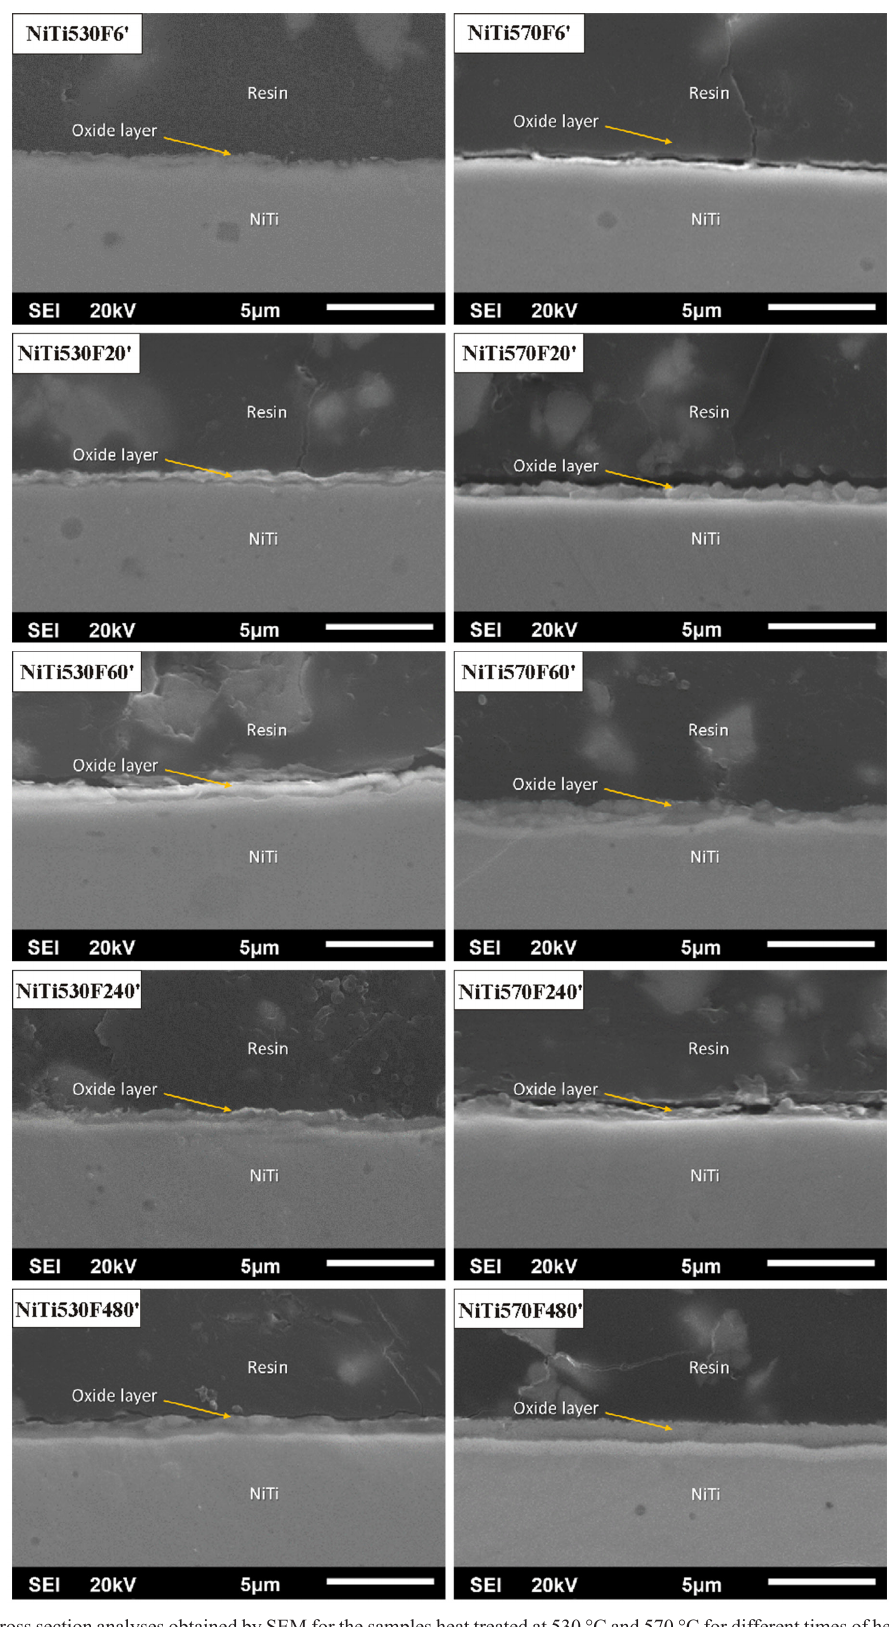
Figure 4. Cross section analyses obtained by SEM for the samples heat treated at 530 °C and 570 °C for different times of heat